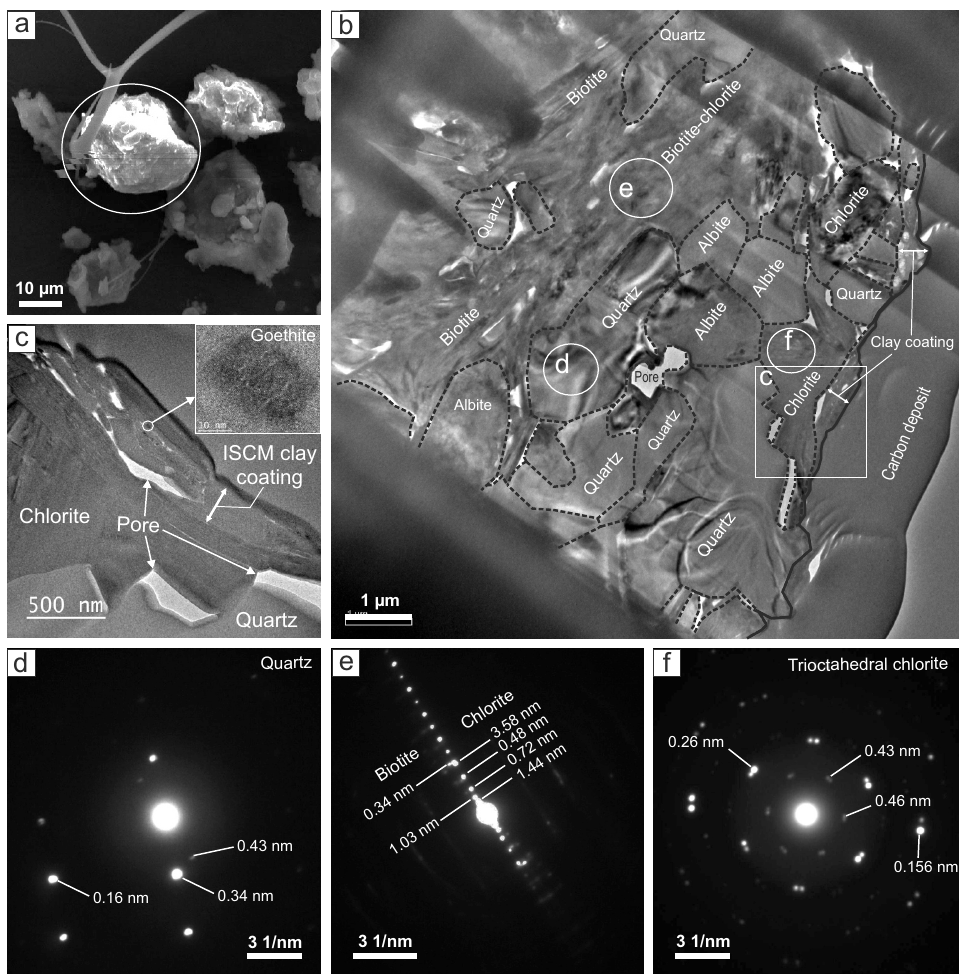
Figure 13. Rock fragment dust particle from 2012 Asian dust. (a) SEM image of the dust particle. (b) Overall TEM image of the FIB slice prepared from the rock fragment particle in (a) . (c) TEM image magnified from the box in (b) showing the coatings of oriented nano-thin clay minerals with pore and goethite nanograins. (d, e, f) Electron diffraction patterns of the areas marked with